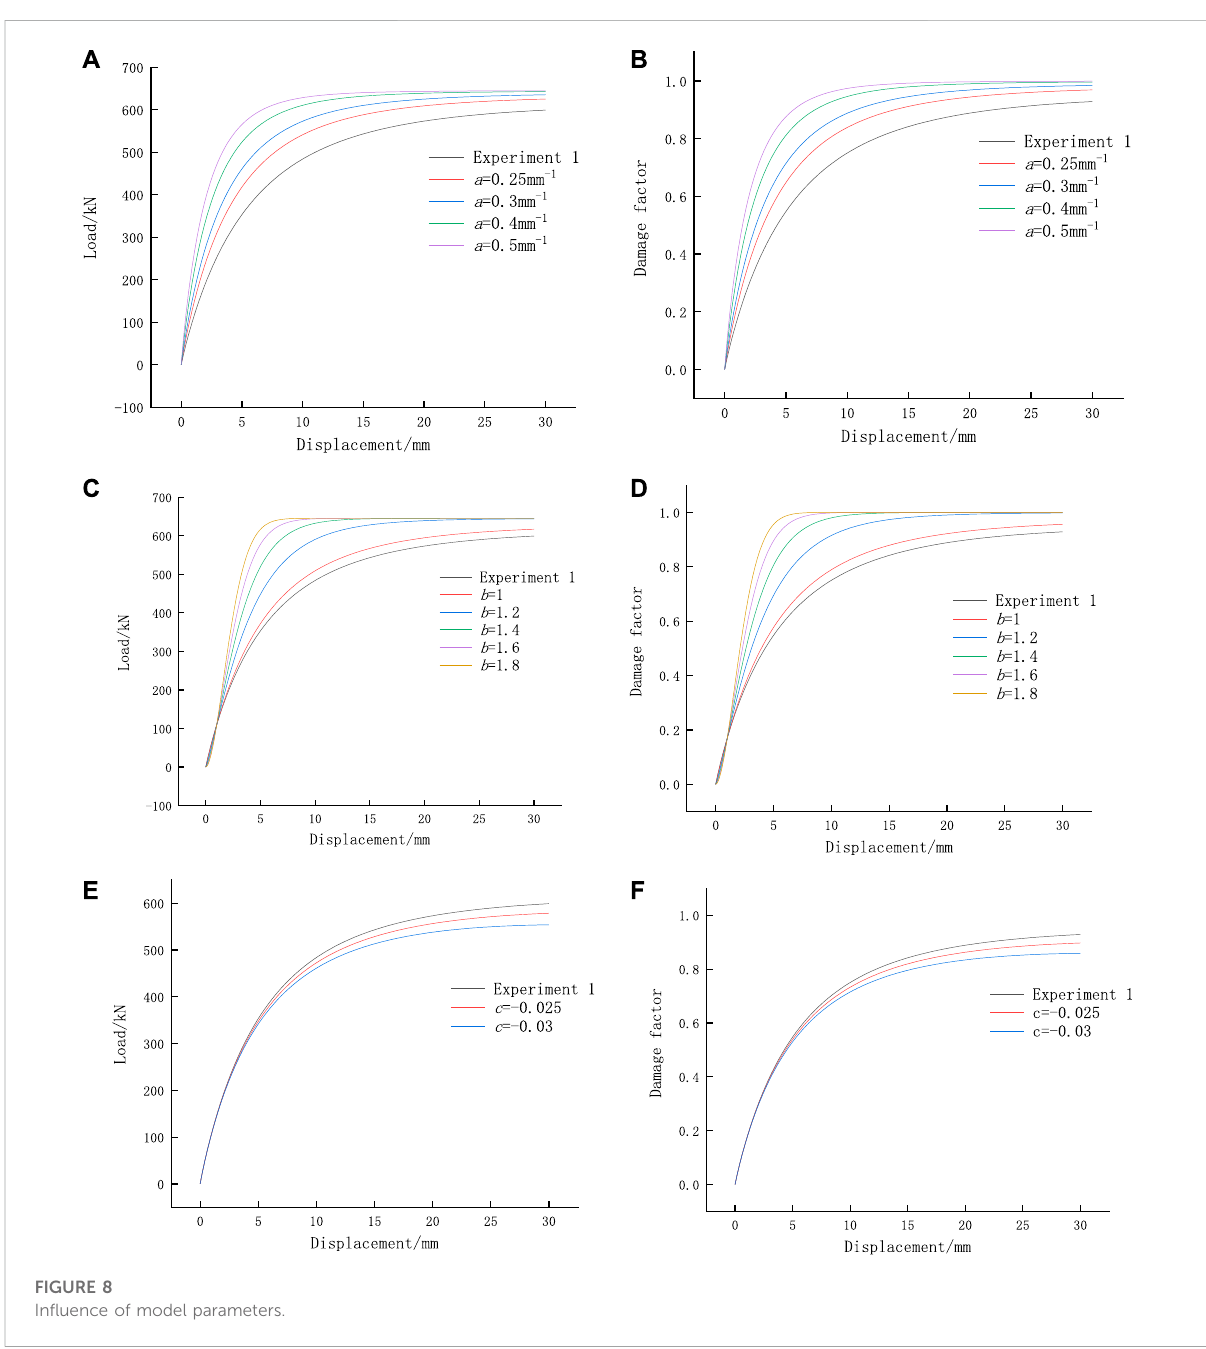
FIGURE 8 In fl uence of model